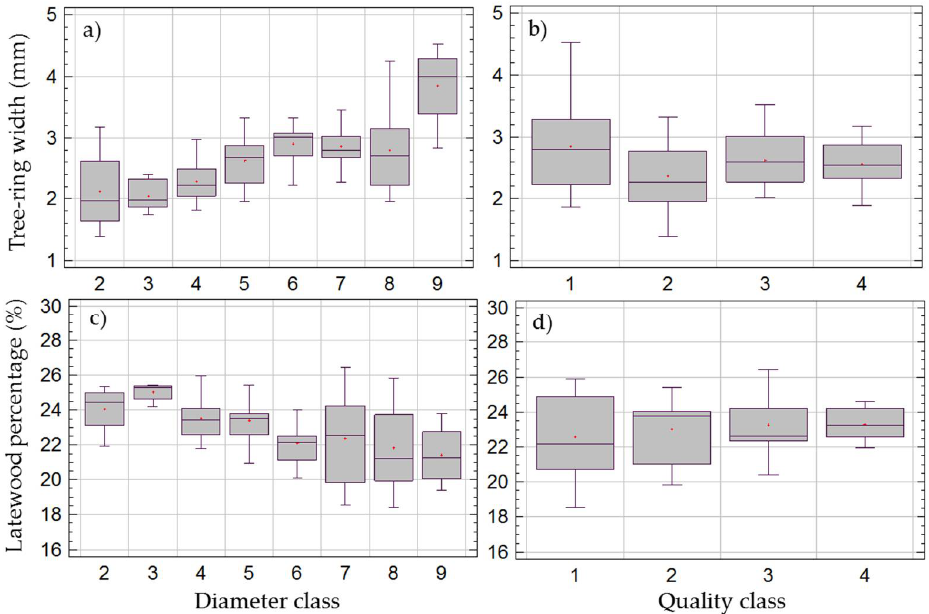
Figure 8. Distribution and interdependence between tree-ring width in relation to the log diameter ( a ) and quality class ( b ); latewood percentage in relation to the log diameter ( c ) and quality class of logs ( d ).